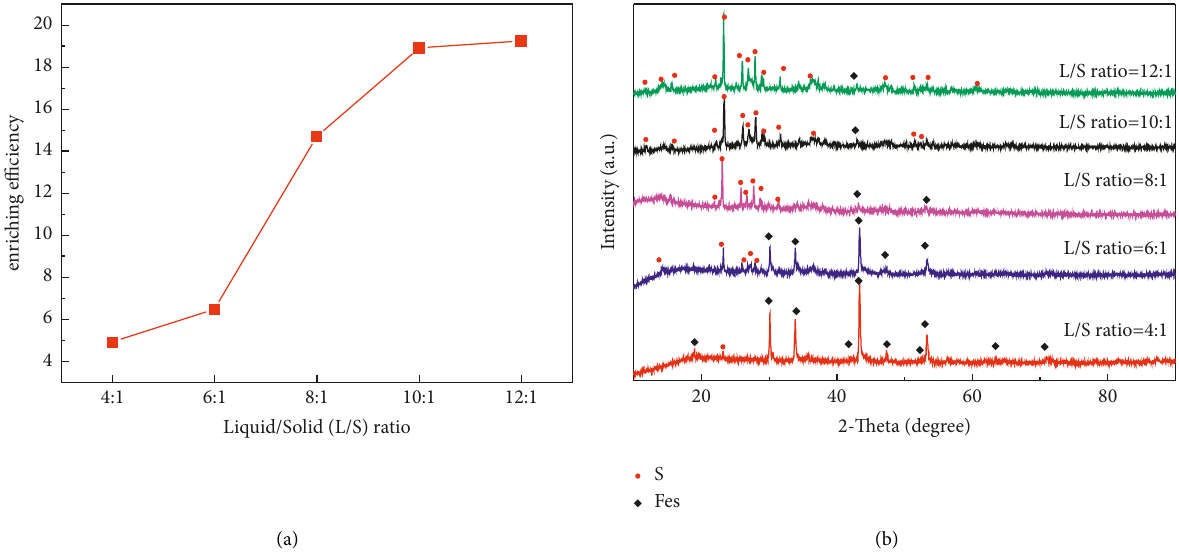
Figure 9: Effects on (a) Pt enriching efficiency and (b) XRD analysis of leaching residue with different L/S